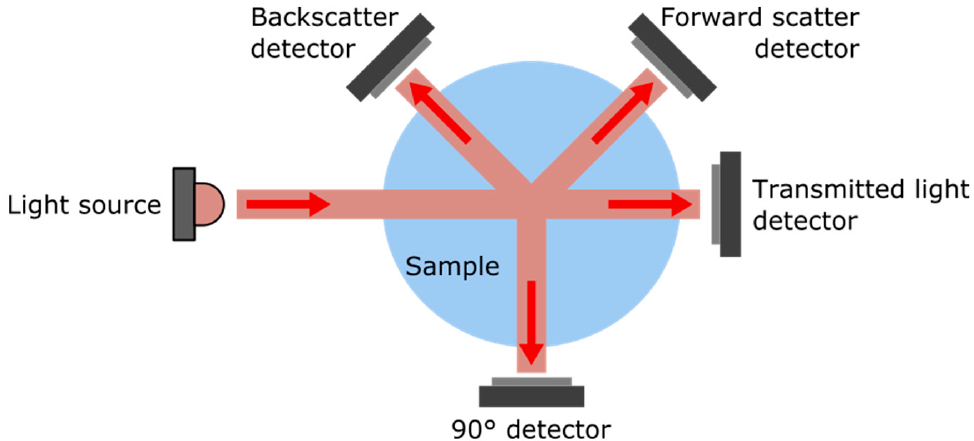
Figure 1. Illustration of the most common optical configurations adopted in turbidity measurement devices.